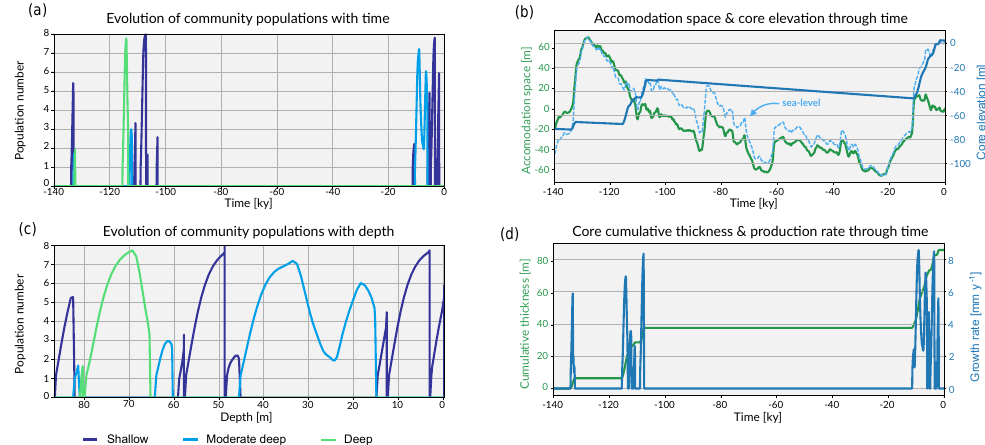
Figure 7. Similar to the previous case, these graphs shows in panels (a, c) the evolution of each community in the form of population number with time and depth. Panel (b) shows the evolution of the accommodation space and core elevation through time in relation to the imposed sea-level curve. Panel (d) presents the temporal evolution of the cumulative thickness as well as the total coral production